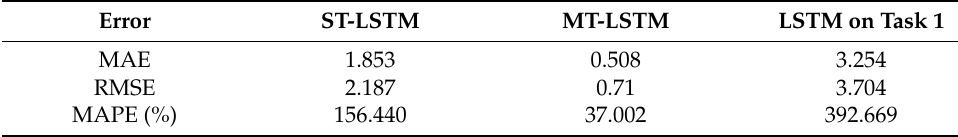
Figure 8. Prediction results of MT-LSTM, ST-LSTM, and LSTM for S3. Table 4. Error results of MT-LSTM, ST-LSTM, and LSTM for S3. Table 3. Error results of STGP and MTGP for S3.